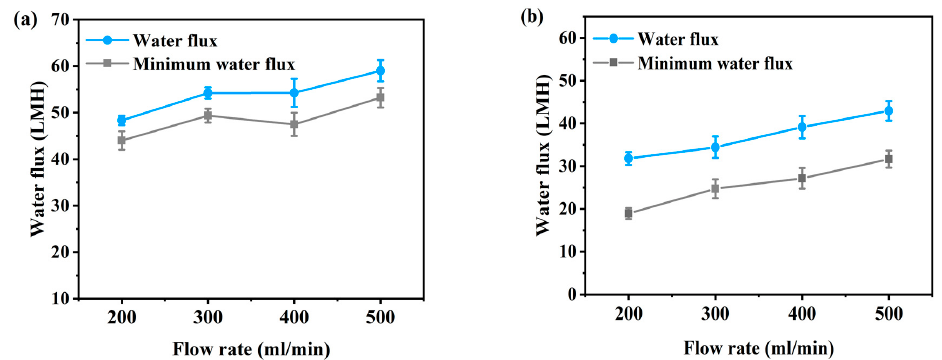
Figure 2. ( a ) Average water flux and minimum water flux of AL-FS mode and ( b ) average water flux